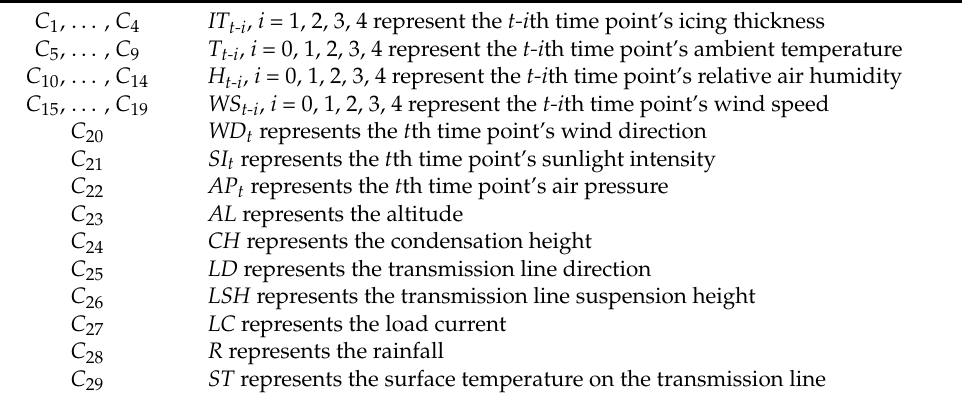
Table 1. The full candidate